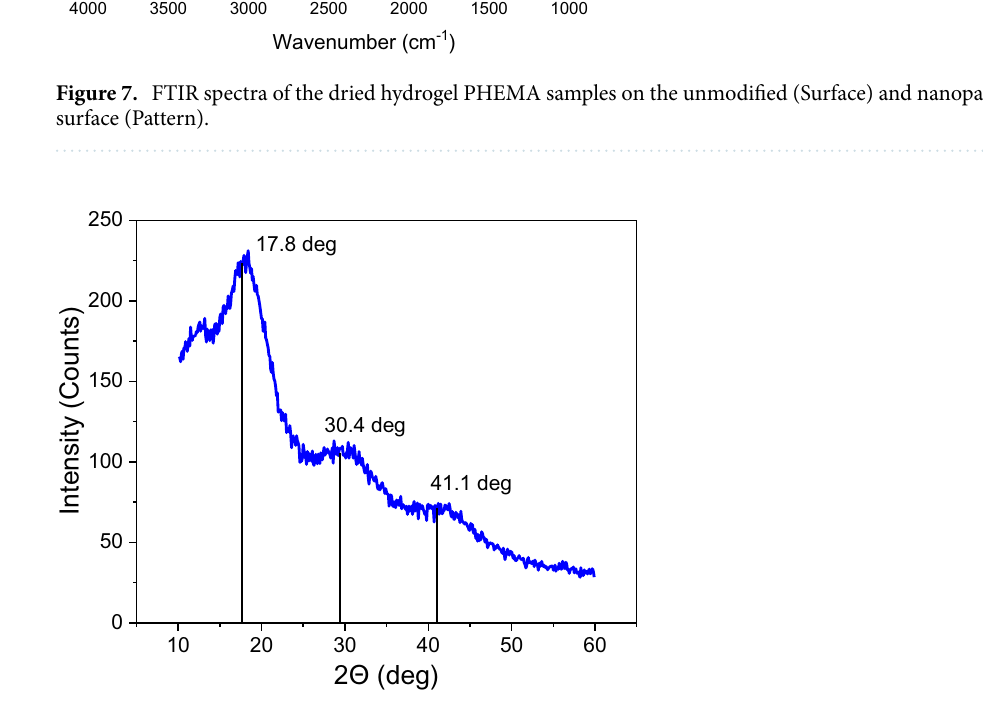
Figure 8. Radial intensity profile obtained from WAXS measurement of the dried PHEMA hydrogel sample. The peak positions are marked by vertical